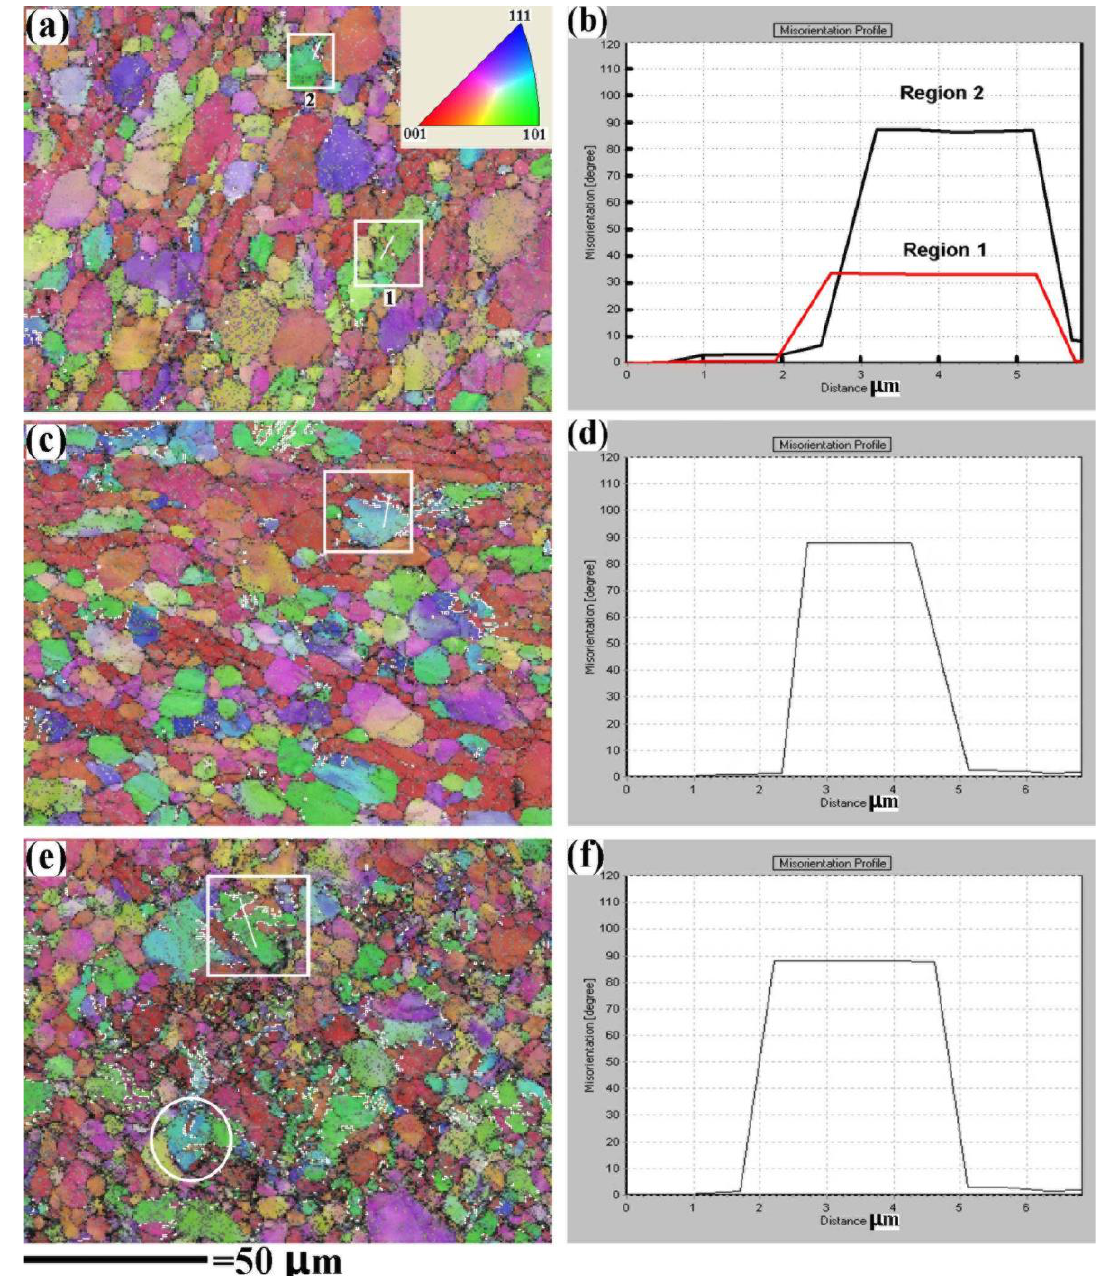
Figure 4. Twinning deformation behavior of the mill-annealed Ti-6Al-4V alloy plate after the strain- limited ( ε = 10%) dynamic compression test. ( a ) OIM of the strain-limited RD specimen, RD is perpendicular to the micrograph. ( b ) Misorientation profile of the line in region 1 and region 2 in ( a ). ( c ) OIM of the strain-limited TD specimen, TD is perpendicular to the micrograph. ( d ) Misorientation profile of the line in the region of ( c ). ( e ) OIM of the strain-limited ND specimen, ND is perpendicular to the micrograph. ( f ) Misorientation profile of the line in the region of ( e